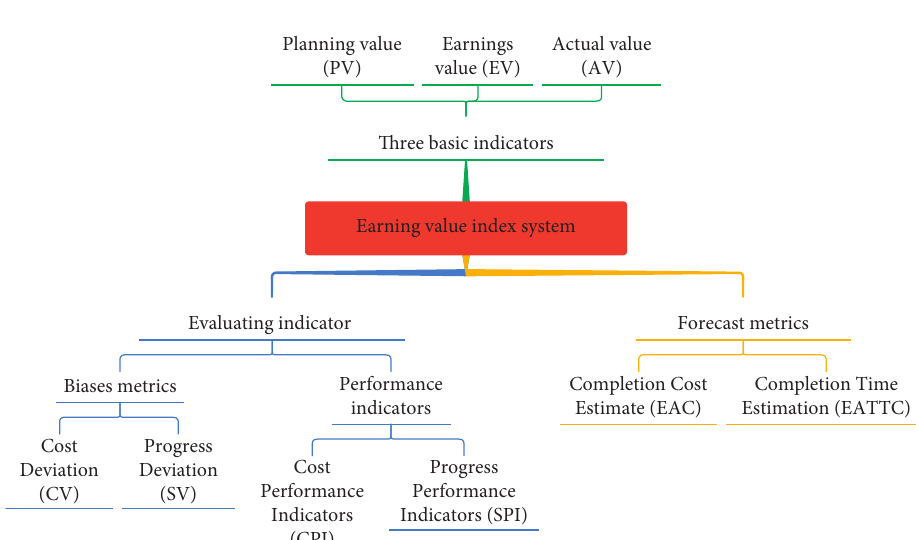
Figure 6: The structure of the information platform.